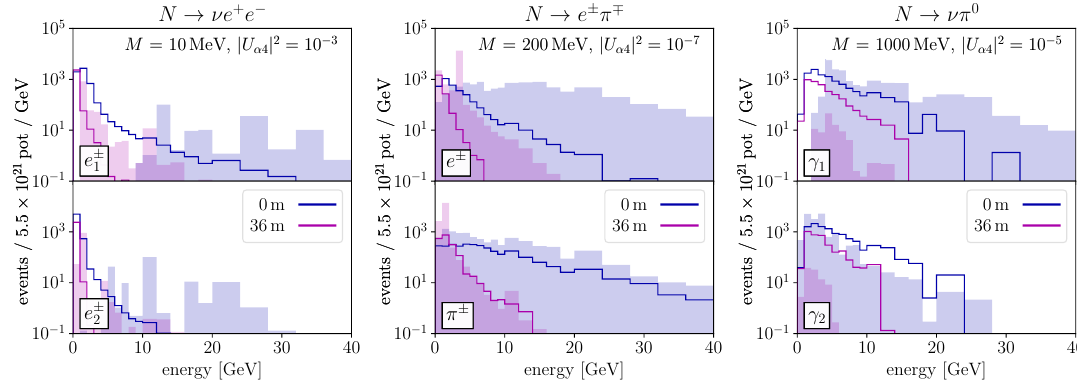
Figure 9 . Signal and background event spectra at the DUNE near detector complex for specific HNL decay modes. Blue and purple unshaded histograms correspond to the number of signal events per GeV at the on-axis location and at 18 m off-axis, respectively. Shaded histograms represent the corresponding backgrounds. The three panels correspond to the most sensitive decay channels in the absence of backgrounds at M = 10 MeV (left panel), M = 200 MeV (middle panel), and M = 1000 MeV (right panel), respectively, as indicated in the plots. For all decay channels included here ( N → νe + e − in the left panel, N → e ± π ∓ in the middle panel, N → ν + ( π 0 → γγ ) in the right panel), we show the spectra of the two visible final state particles separately. If the particles are identical (up to their charge, which we conservatively assume not to be measured), the upper histogram corresponds to the more energetic one, while the lower histogram is for the softer particle. Note that the sensitivity estimates discussed below are based on the full two-dimensional event distributions. We observe that the signal-to-background ratio improves significantly when going